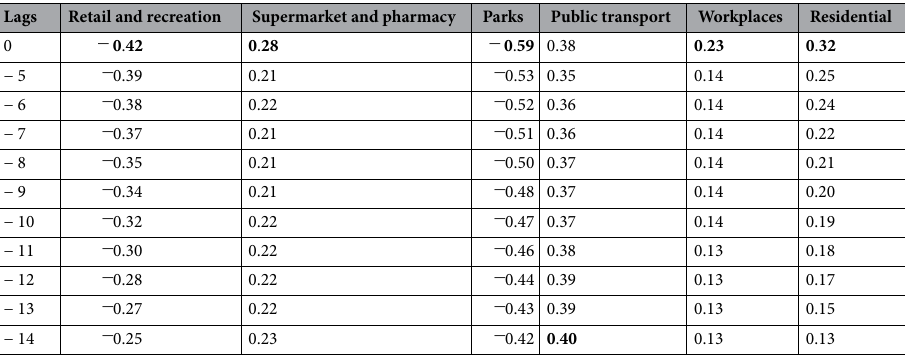
Table 5. Spearman’s correlation between 14-day CI and Google mobility variables for different lags in the mobility time series.